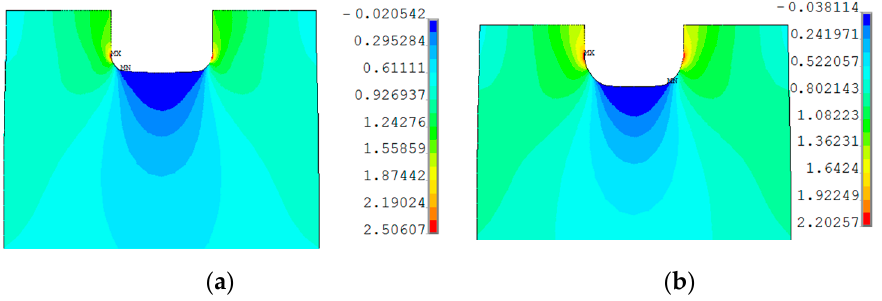
Figure 7. Stress concentration factor for specimens with square holes and rounded corners: ( a ) fillet radius R2; and ( b ) fillet radius R4. Table 5. Stress concentration factor values for tested specimens.